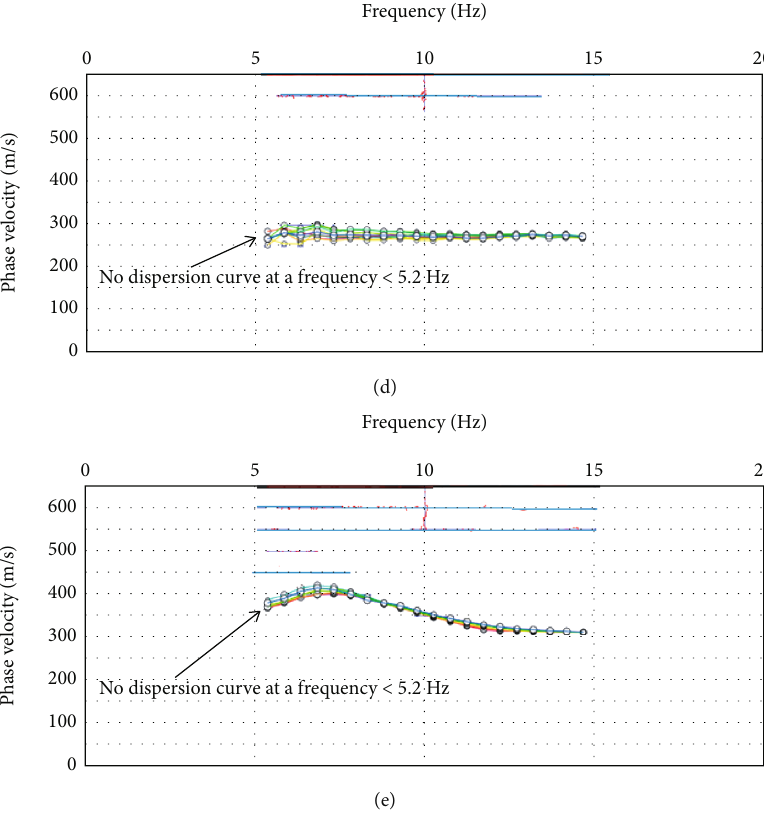
Figure 7: Dispersion curves from (a) MASW 1, (b) MASW 2, (c) MASW 3, (d) MASW 4, and (e) MASW